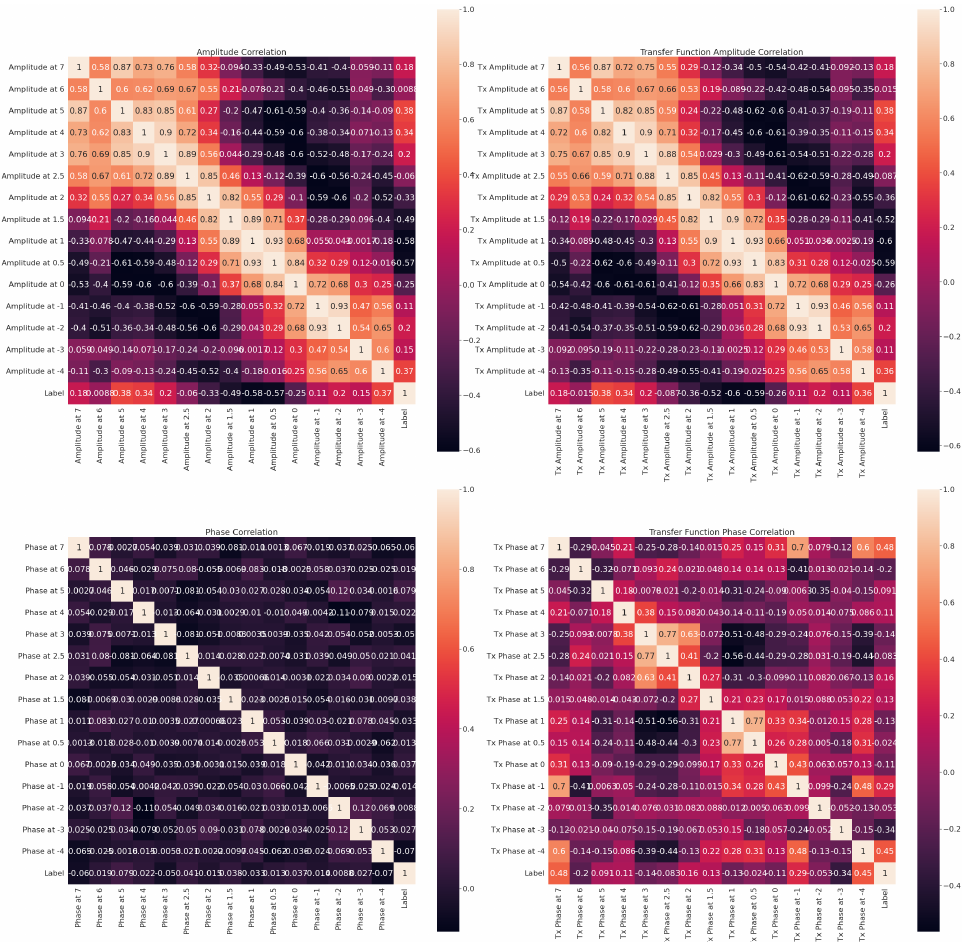
Figure 17. The correlation matrices for the Amplitude data ( top left ), the Transfer Function Amplitude data ( top right ), the Phase data ( bottom left ), and the Transfer Function Phase data ( bottom right ) for the full set of